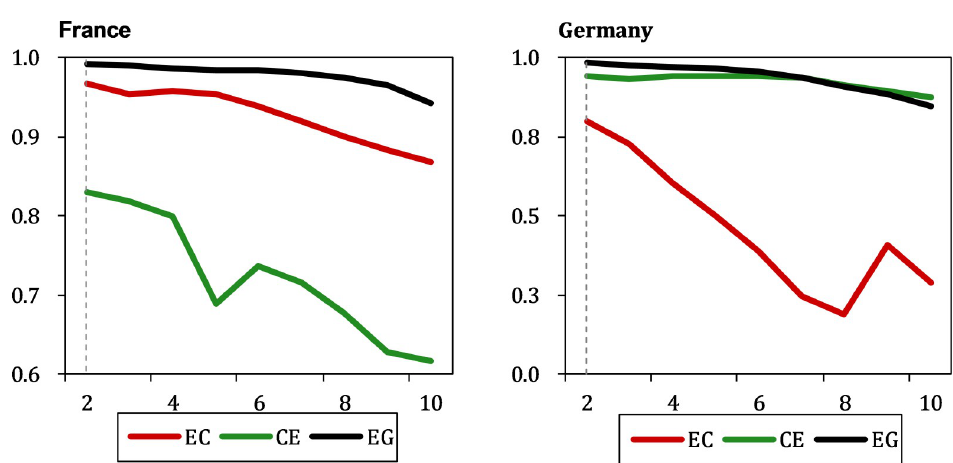
Fig 3. Determining the optimal E of EC, CE, EG for France and Germany.